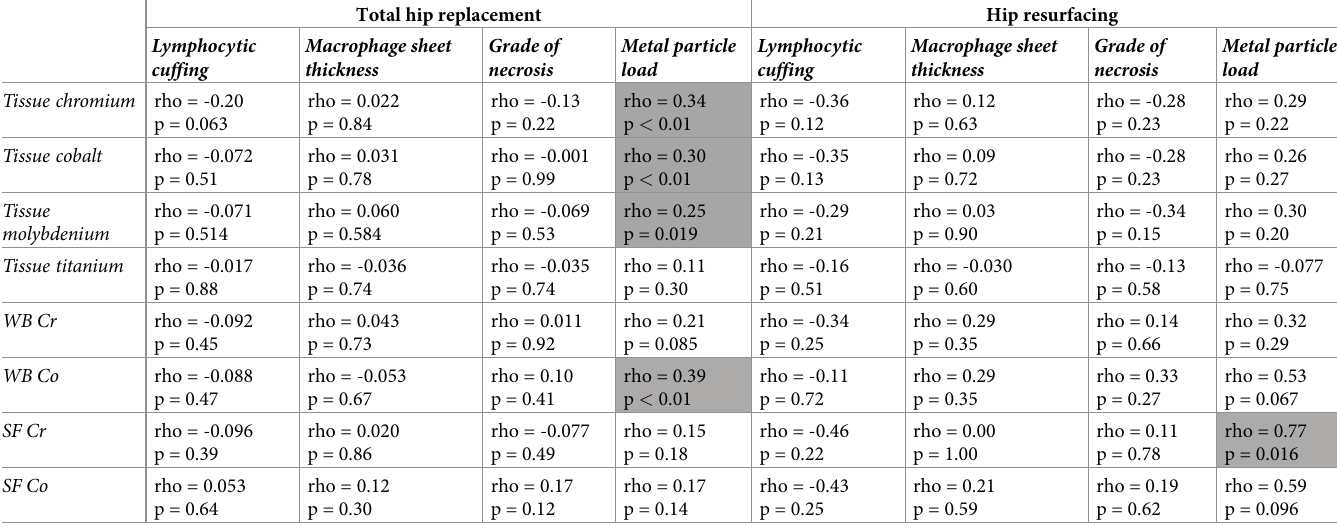
Table 5. Correlations between histological findings, periprosthetic tissue metal concentrations, whole blood metal ion levels (WB) and and synovial fluid (SF) metal ion levels in total hip replacement group (n = 87) and hip resurfacing group (n = 20). Cells containing statistically significant values are colored in